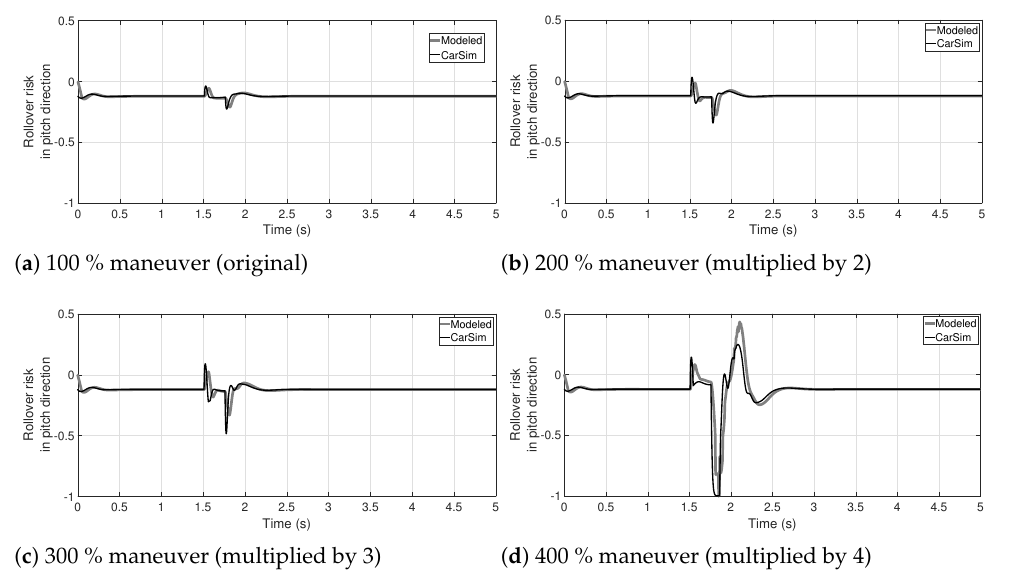
Figure 5. Comparison of the rollover risk in pitch direction ( RI X ) modeled in this paper, and calculated by the vertical forces provided by CarSim, using the front vertical road reference pulse of Figure 2b multiplied by 100, 200, 300 and 400%. The model presented in this paper is enough precise to detect an imminent longitudinal rollover; with the 400% impulse, the front wheel is lifted off the ground.